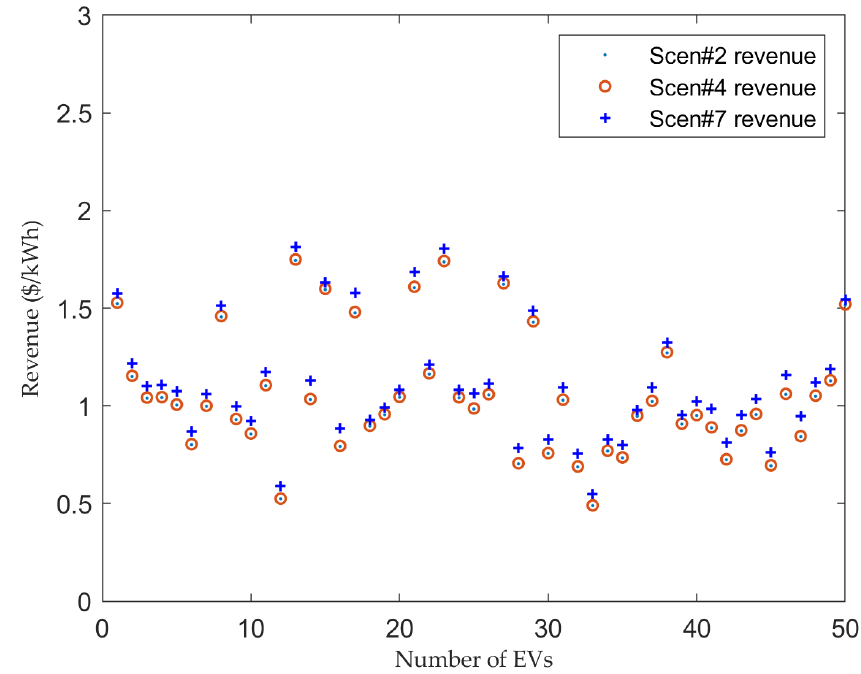
Figure 15. Daily revenue for each